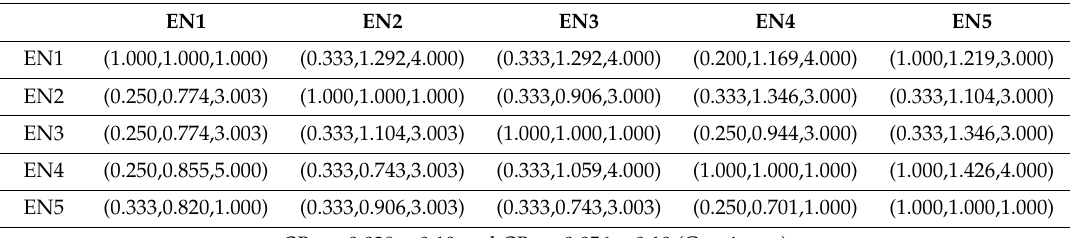
Table A9. Fuzzy pairwise comparison matrix with respect to the environmental (EN)